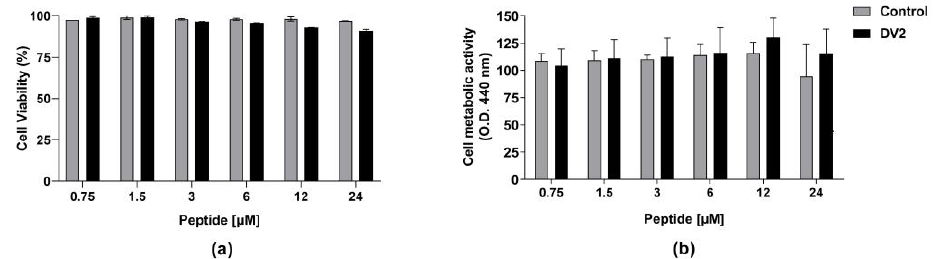
Figure 2. Cytotoxic effects of the DV2 peptide on eukaryotic cells. Vero CCL-81 cell monolayers were treated with increasing concentrations (0.75–24 µ M) of the DV2 peptide for up to 24 h. Cell samples were exposed to the peptide solvent (DMSO) at the same volume/dilution (control). ( a ) Percentage of live cells obtained by flow cytometry analyses. ( b ) Cell proliferation measured by metabolic activity using the WST-1 reagent. Data are presented as mean ± SEM of live cells normalized to the respective control.